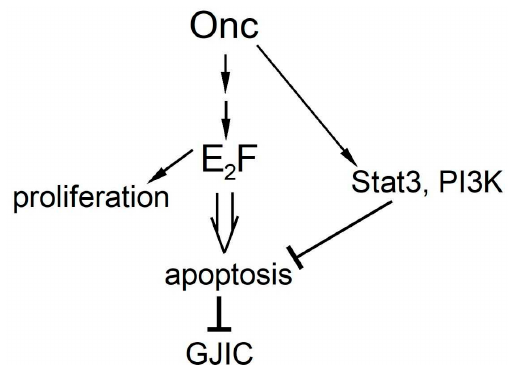
Figure 4. Model on PI3k and Stat3, apoptosis and GJIC. A number of oncogenes (Onc) activate the transcription factor E2F family, through a number of steps [111]. E2F, in turn, can induce apoptosis through p53-dependent and independent pathways. Interestingly, the oncogene also activates PI3k and Stat3 which block apoptosis, so that neoplastic transformation can occur. Upon PI3k and Stat3 inhibition however, apoptosis will suppress GJIC.